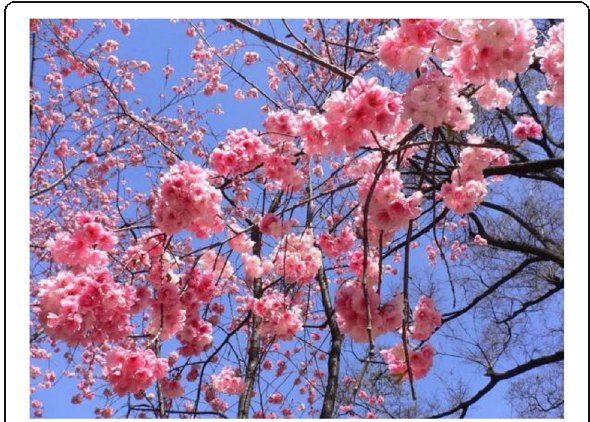
Fig. 8 Cherry blossom